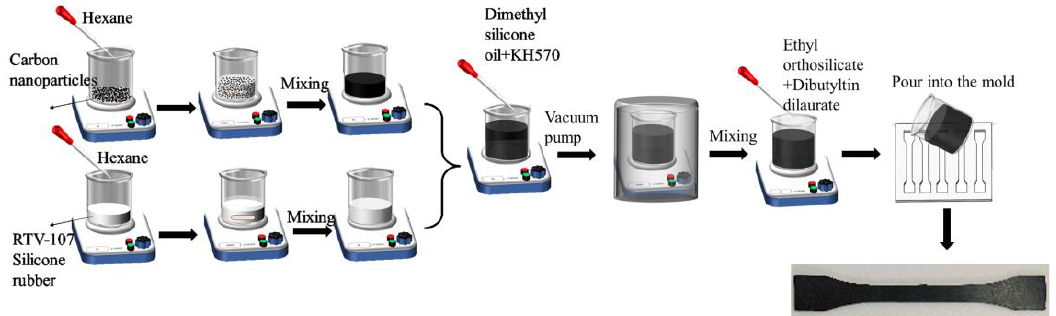
Figure 10. Preparation process of the CNPs − filled silicone rubber.